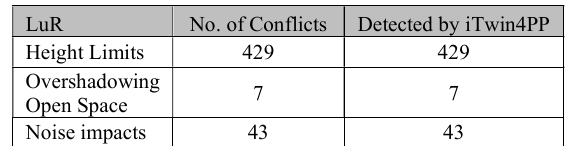
Table 2 . Evaluation results specifying the number of conflicts that were expected to be